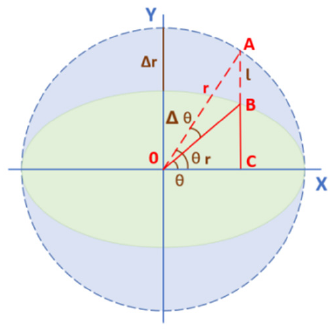
Figure 2. Graphical analysis of the Lissajous sine error.